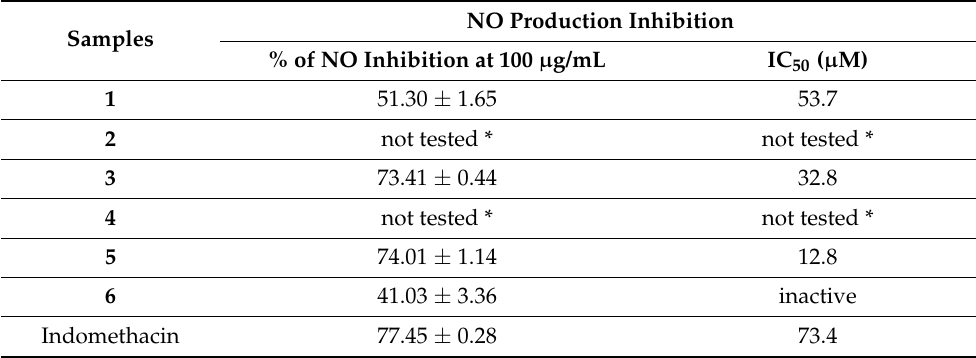
Table 4. Nitric oxide production inhibition activity of compounds 1 –